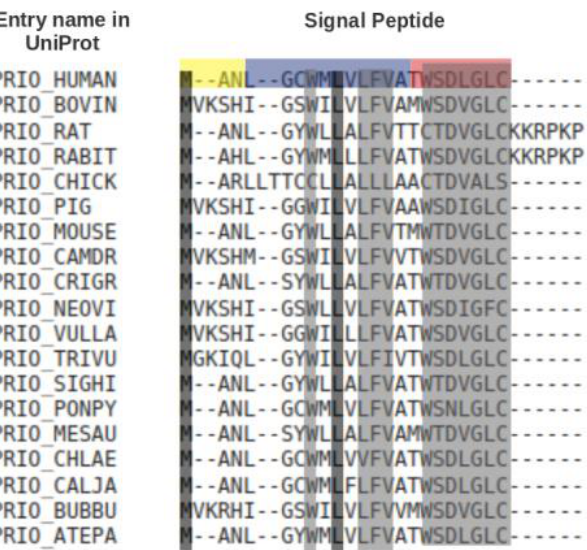
Figure 2. Multiple sequence alignment, produced by Kalign [21], of the signal peptides of the prion protein (PRNP) [22] from different organisms. For this, the signal peptide sequences of the prion protein from 68 organisms were collected from UniProt. CD-Hit [23] was used to remove